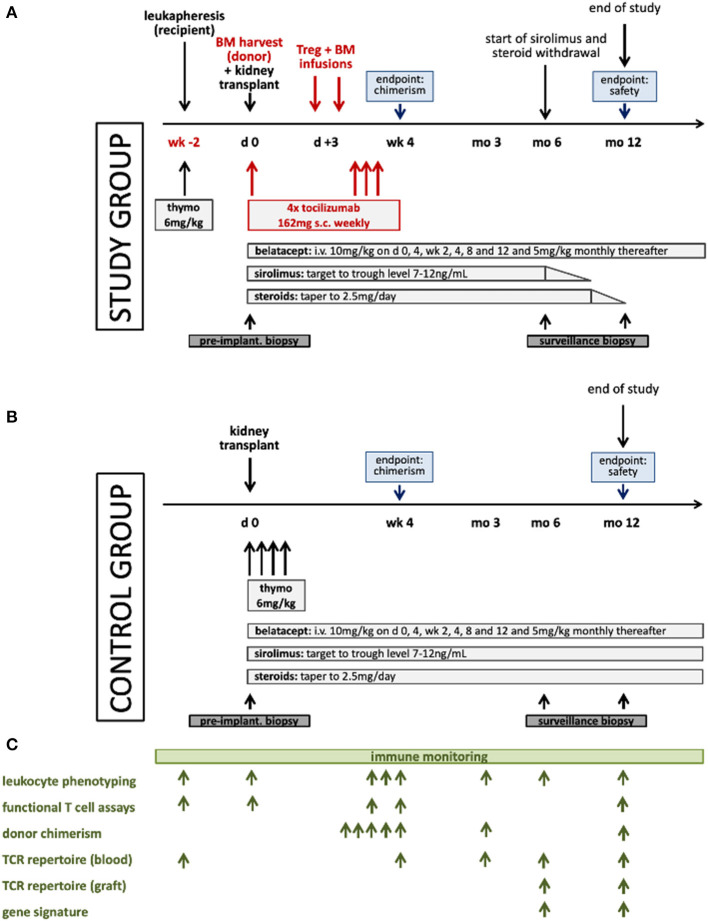
Schematic illustration of the treatment protocols for the study (A) and the control (B) groups and the immune monitoring plan (C). Thymo denotes thymoglobulin.